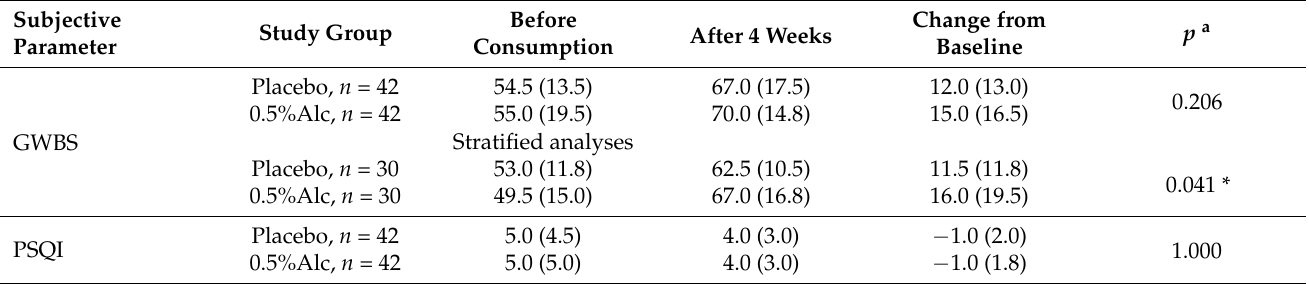
Table 3. Comparative results for GWBS and PSQI scores between the study groups. Subjective Study